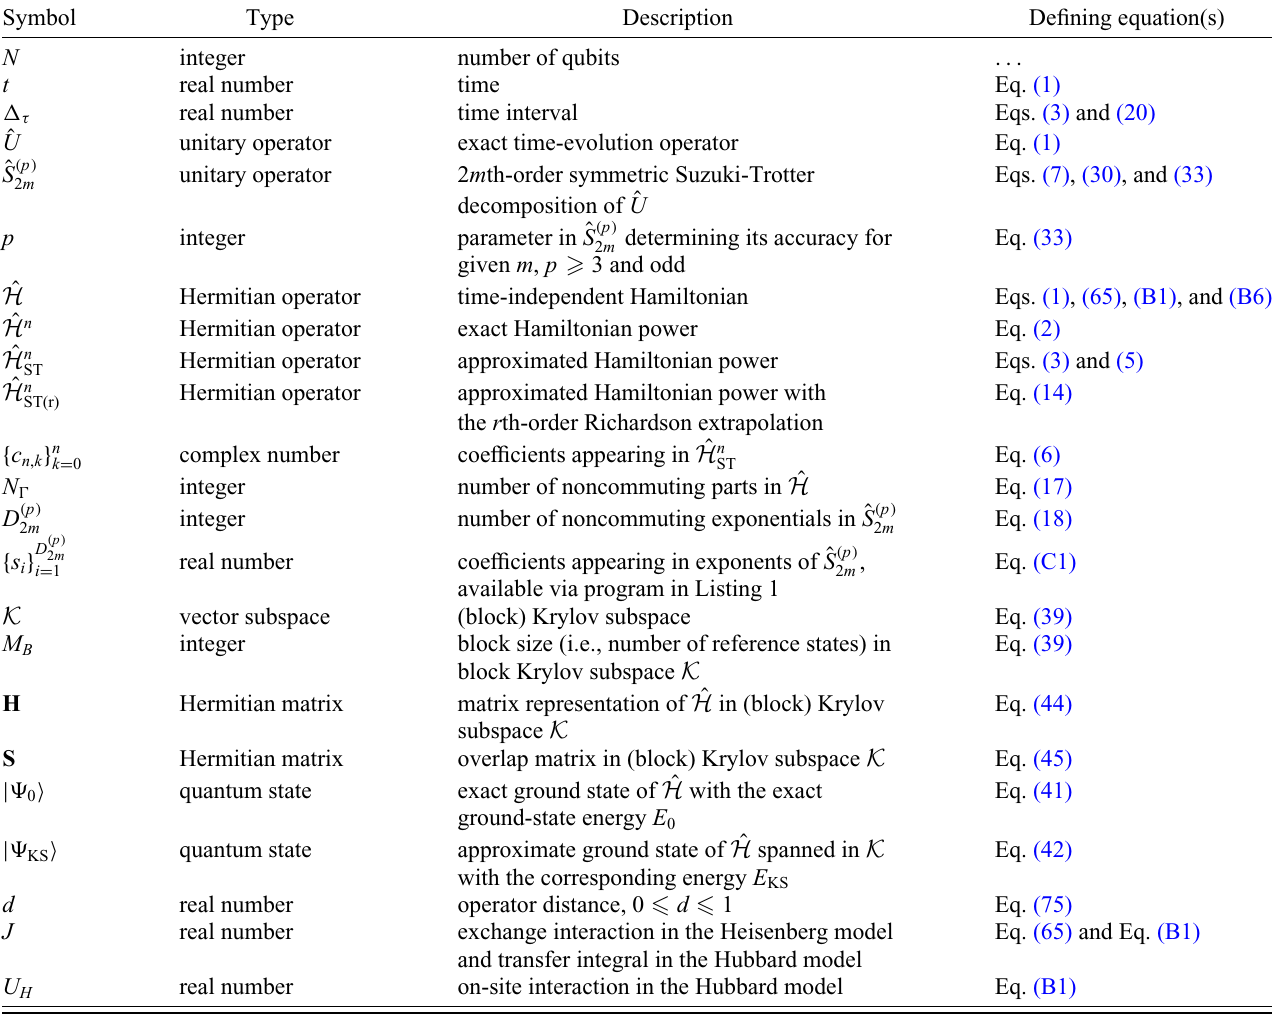
TABLE I. Major symbols used in this